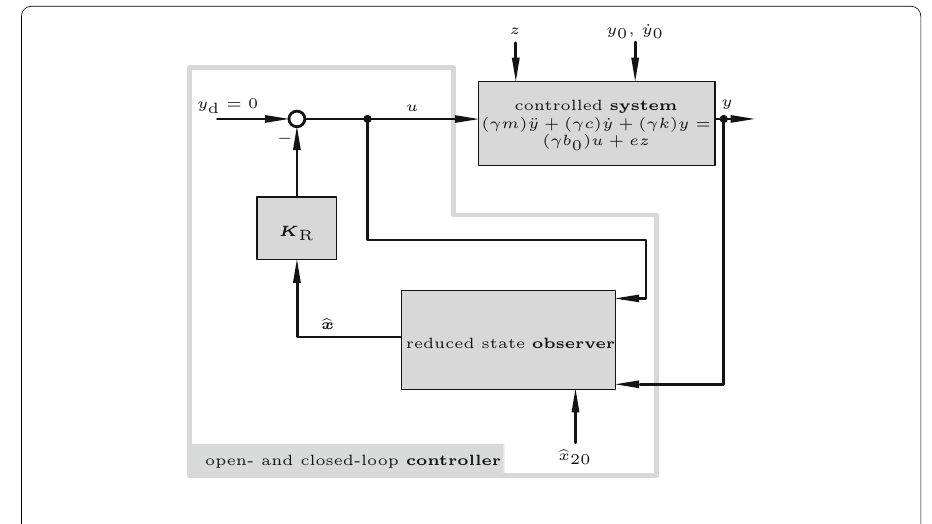
Fig. 9 Block diagram for the controlled system with following state observer [21], p.